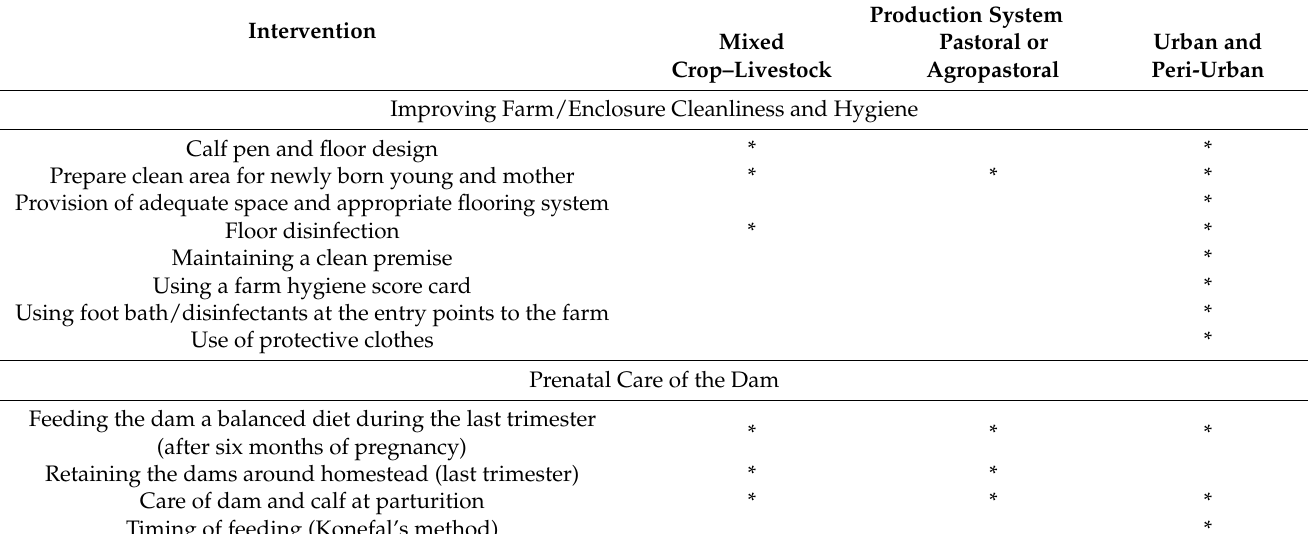
Production System Mixed Pastoral Crop–Livestock